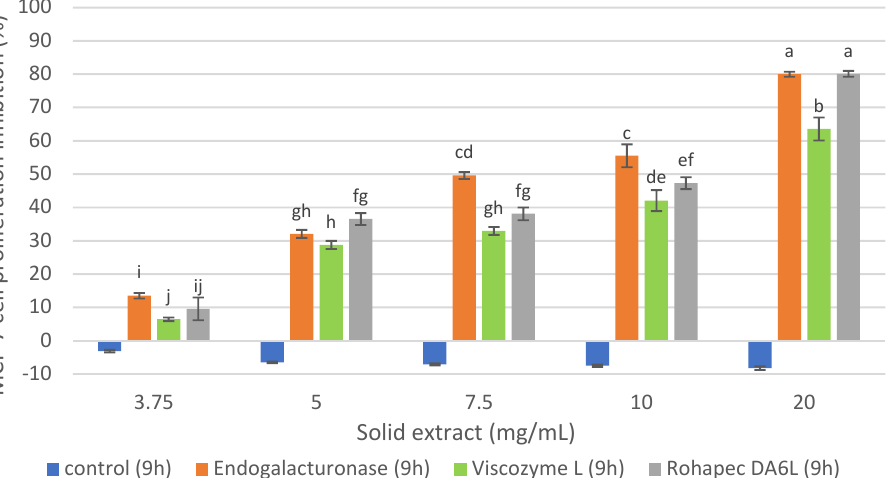
Figure 2. MCF-7 cell proliferation inhibition of the oligosaccharide extract obtained with commercial enzyme preparations from IRM at pH 4, 50 °C, S/L 1/20, E/S 1% p/p. Percentages of inhibition are calculated in reference to the signal of cells grown of extract-free cell culture media. Mean ± SD ( n = 3). The median that does not share a letter are significantly different ( p > 0.05), comparing all values together with ANOVA and Tukey’s test.